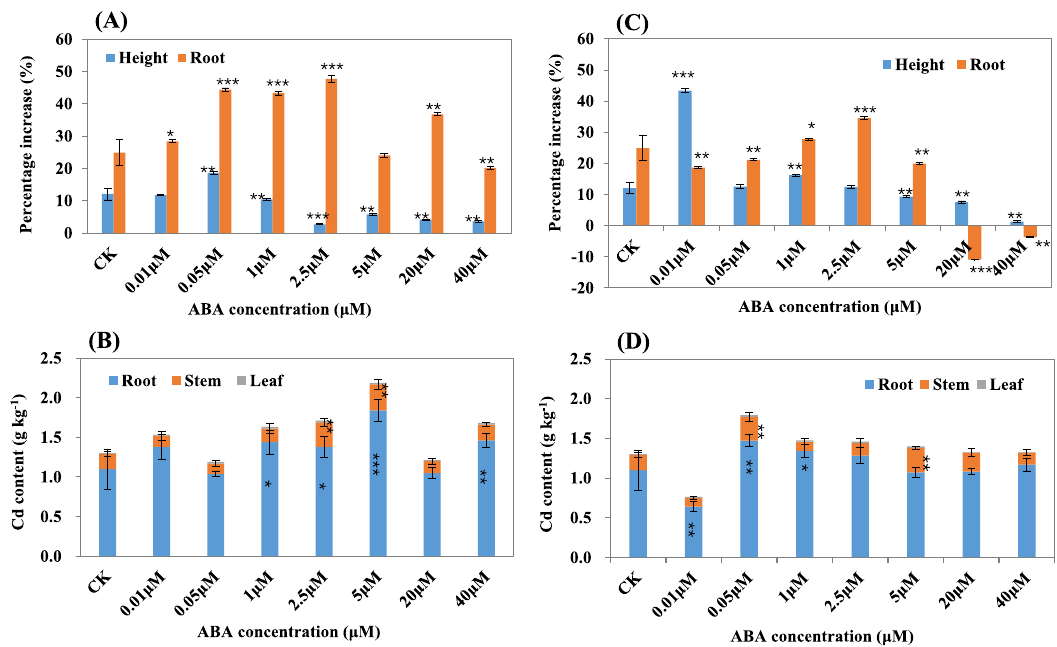
Figure 2. Phenotype and Cd content of ramie plants under ABA treatment. ( A ) and ( C ) Increased rate of plant height and root under ABA treatment by spraying ABA on ramie plants (SORP) and adding ABA directly to the culture solution (ADCS), respectively. Data were calculated by the formula: 100·(A 10 − A 0 )/A 10 , A 0 and A 10 denote the value of plant height or root length after 0 and 10 days of ABA treatment, respectively. ( B ) and ( D ) Cd content of leaf, stem and root under ABA treatment by SORP and ADCS, respectively. Data are means ± SD of three biological replicates. Each replicate consisted of material from ten plants. *, ** and ***denote statistically significant differences from the control (0 mg L −1 ) at P < 0.05, P < 0.01 and P < 0.001,